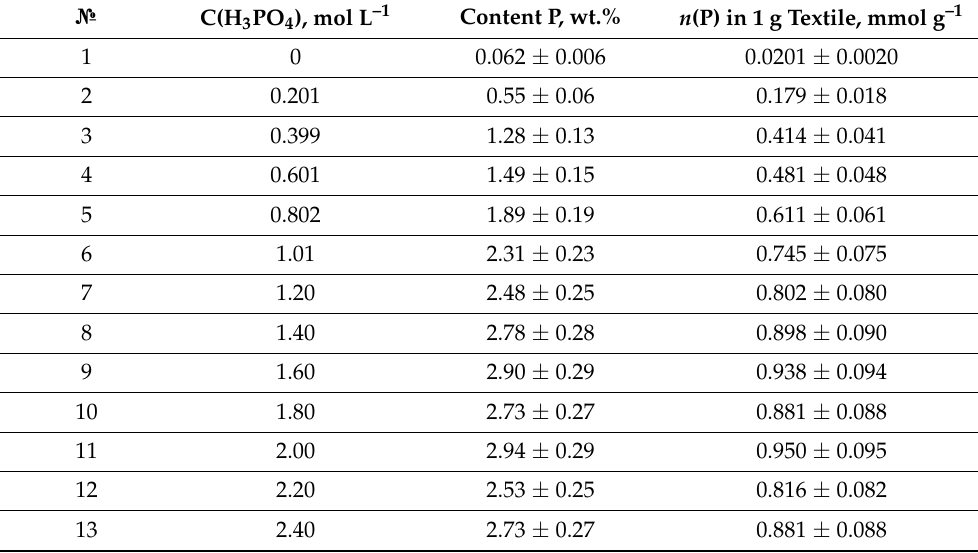
Figure 1. Effect of phosphoric acid content on the standard maximum tensile strength for phosphorylated cotton fabric samples. Table 1. Results of the phosphorus content determination in the cotton cellulose samples before and after phosphorylation, obtained by the spectrophotometric method based on the color intensity of the reduced phosphorus molybdenum complex.